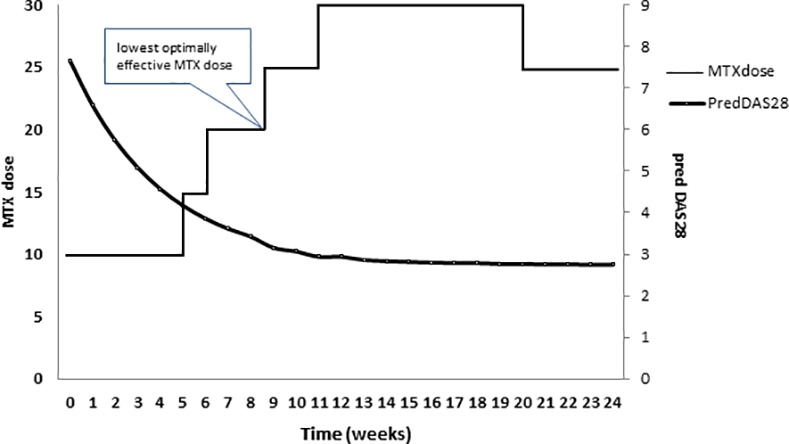
Example of one patient’s determination of LOED based on MTX doses over time along with estimated DAS28.